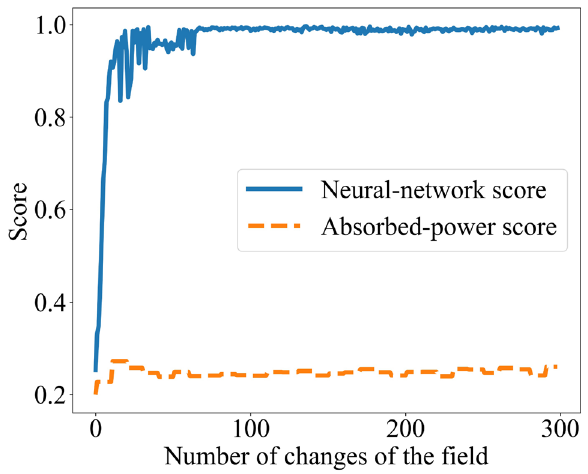
Figure 4. Quantification of a many-body system’s classification ability: A spin glass classified a drive as one of five possibilities. The blue, upper curve represents the system’s classification ability, as quantified by a bottleneck neural network. The orange, lower curve represents the classification ability as quantified with the absorbed power. The neural-network score rises to near the maximum, 1.00. The thermodynamic score exceeds the random-guessing score, 1/5, slightly. The neural network therefore detects more of the spins’ classification